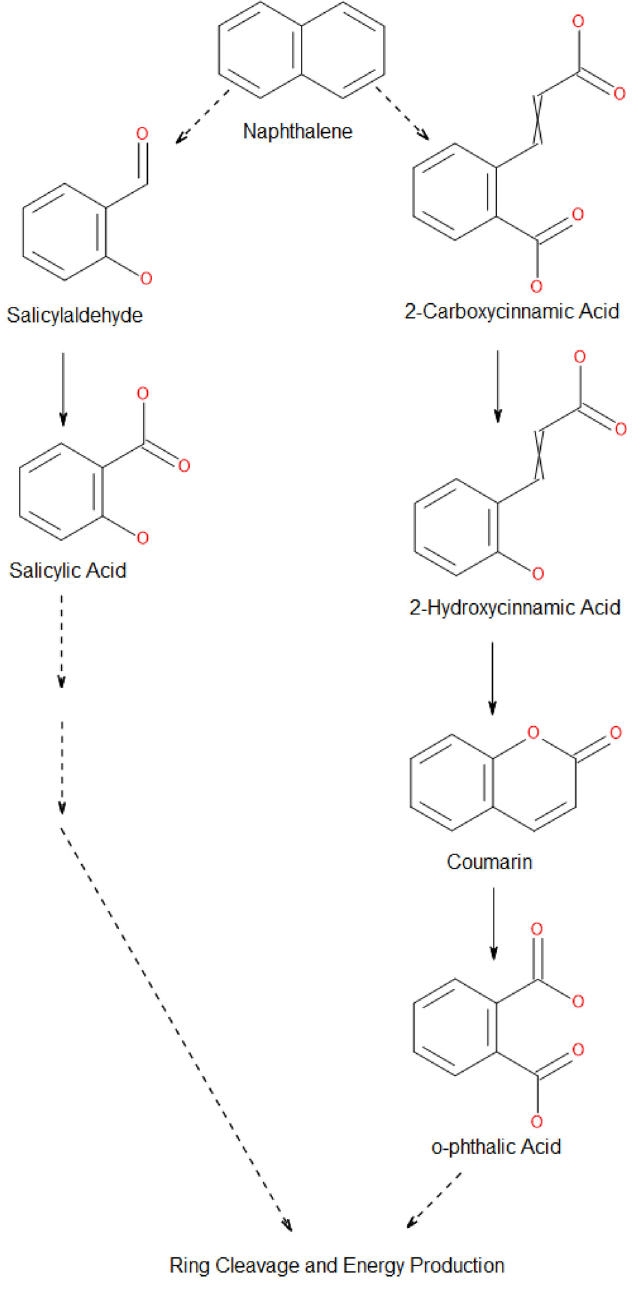
Fig 7. Shown is the peculiar biochemical pathway identified from R . opacus strain M213 utilized for the biodegradation of naphthalene (NAP), as revealed by an intertwined biochemical, genomics and bioinformatics approach. Broken arrows indicate that there are multiple biochemical steps involved between the two compounds that connect the identified metabolic